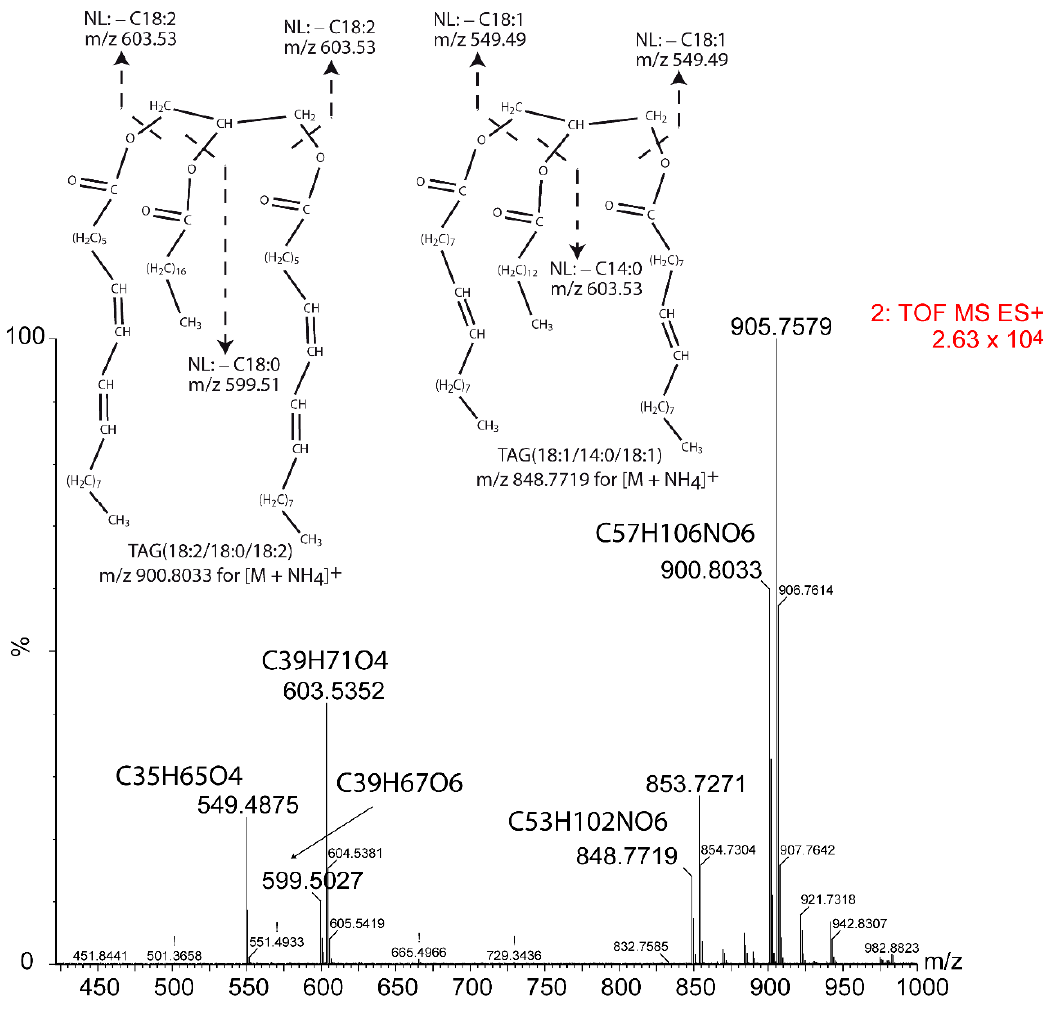
Figure 7. MS E mass spectrum at 6.29 min of two partially co-eluting TAGs. TAG(54:4) has m/z 900.8033 and elemental composition C 57 H 106 NO 6 for the [M + NH 4 ] + adduct; TAG(50:2) has m/z 848.7719 and elemental composition C 53 H 102 NO 6 for the [M + NH 4 ] + adduct. The elemental compo- sition of each fragment is also indicated. NL means neutral loss.